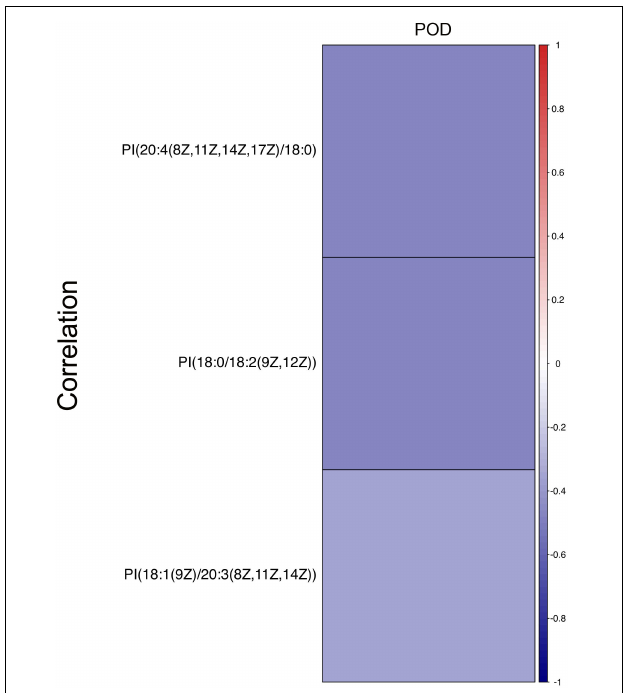
FIGURE 5 | Correlation analysis between three PIs and the incidence of POD after cardiac surgery. Different colors represent different correlation coefficients, red is positive, indicating that the two are positively correlated. Blue is negative, indicating a negative correlation. The present findings suggested that three PIs were negatively correlated with the incidence of POD after cardiac